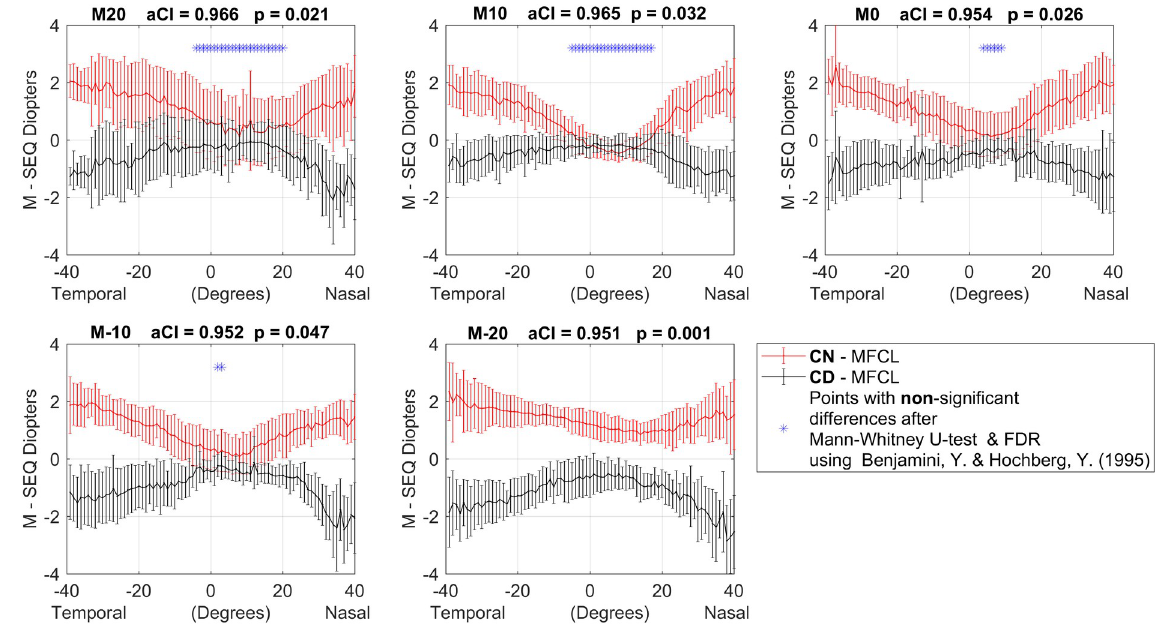
Fig 3. Average and SD of the SE contact lens profiles, after subtracting the naked eye conditions (n = 13). Images from top to bottom and left to right represent the different meridians measured. Y-axis: dioptres scale; X-axis: degrees scale. The points notated with a blue ‘ � ’ are the points where non-significant statistical differences were found, after applying Mann-Whitney-U-test and the Benjamini-Hochberg FDR correction.